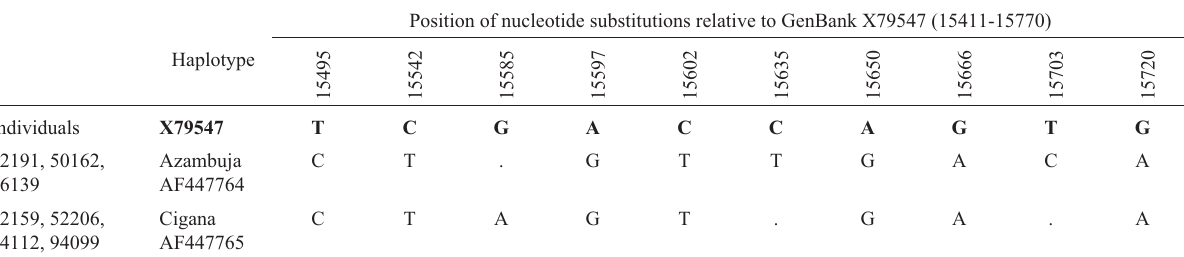
Table I - Sorraia horse haplotype sequences and nucleotide substitutions among the control region sequences, as compared to the reference sequence GenBank X79547. The dots indicate concordance with GenBank X79547. Azambuja and Cigana are the two maternal lines